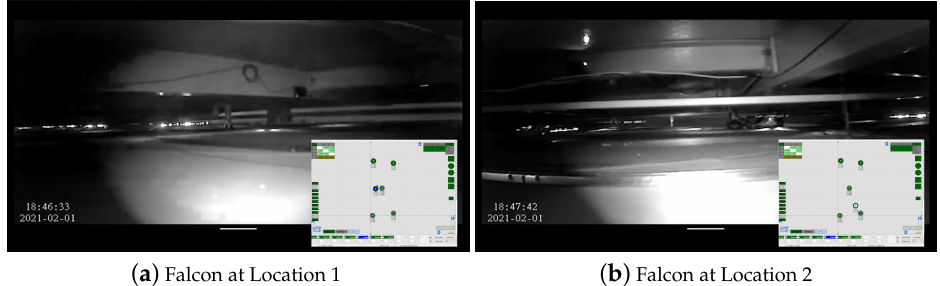
Figure 11. Falcon’s performance on the false ceiling at the SUTD ROAR